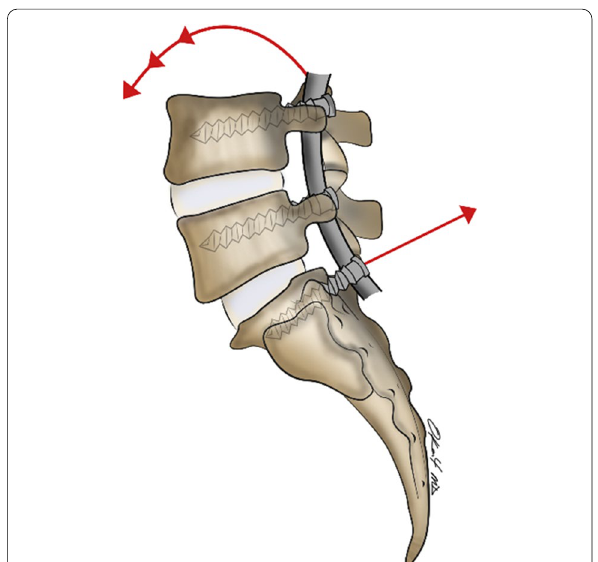
Fig. 1 Long-segment fixations, including the lumbosacral junction, resulting in a strong cantilever effect making the construct more prone to failure [5]